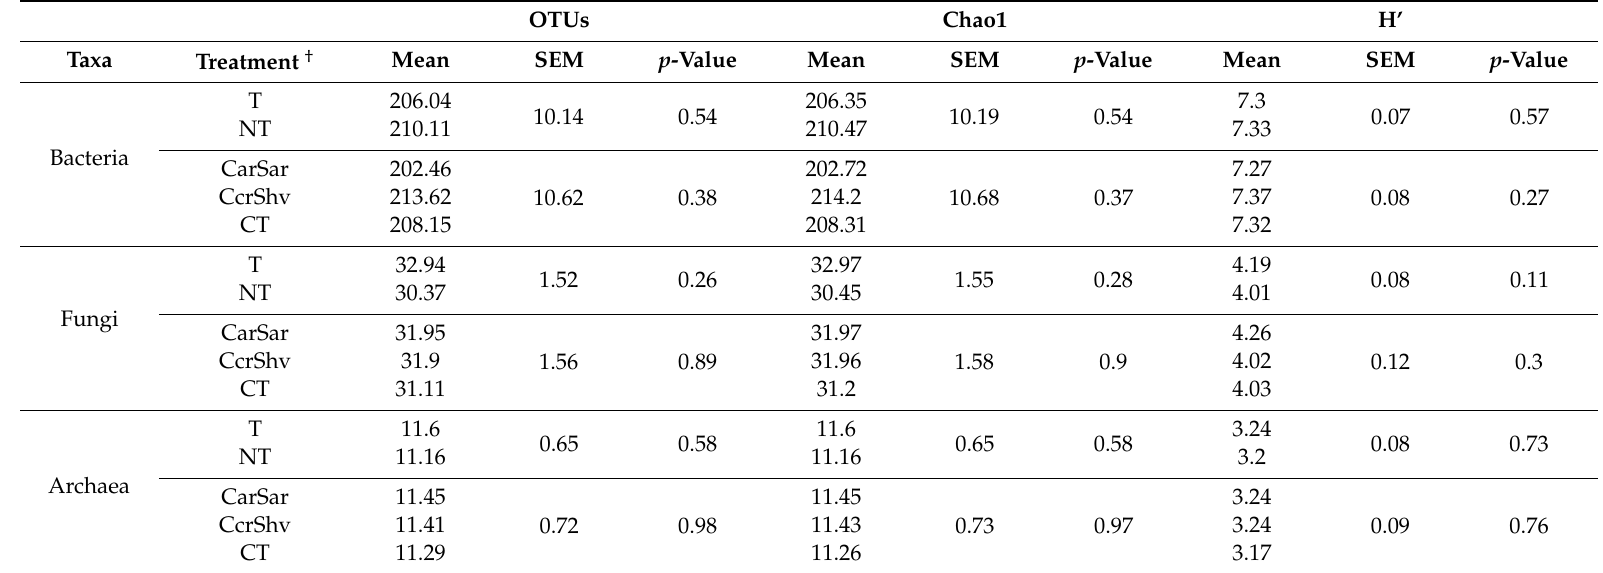
Table 2. Mean values and standard errors of the mean (SEM) for the α -diversity parameters of the observed operational taxonomic units (OTUs), Chao 1 Richness Index (Chao1), and Shannon’s Diversity Index (H’) for bacteria, fungi, and archaea taxa following five years of tillage and cover crop rotation treatments. OTUs Chao1 H’ Taxa Treatment † Mean